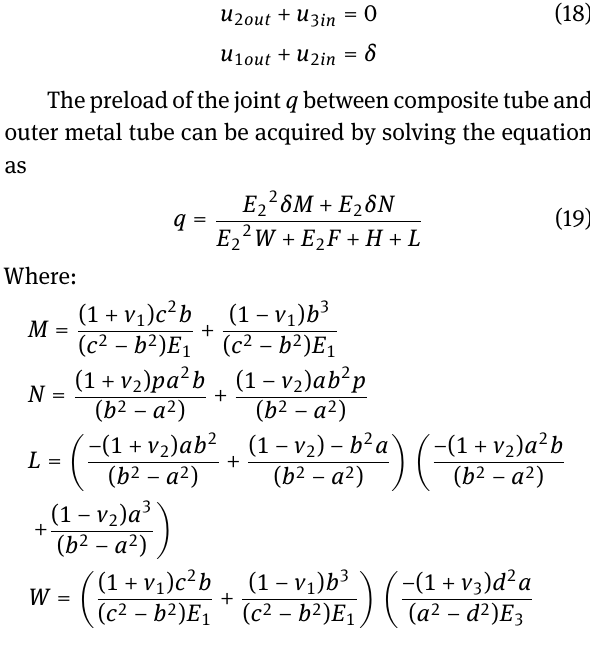
displacements of composite tube and inner metal tube